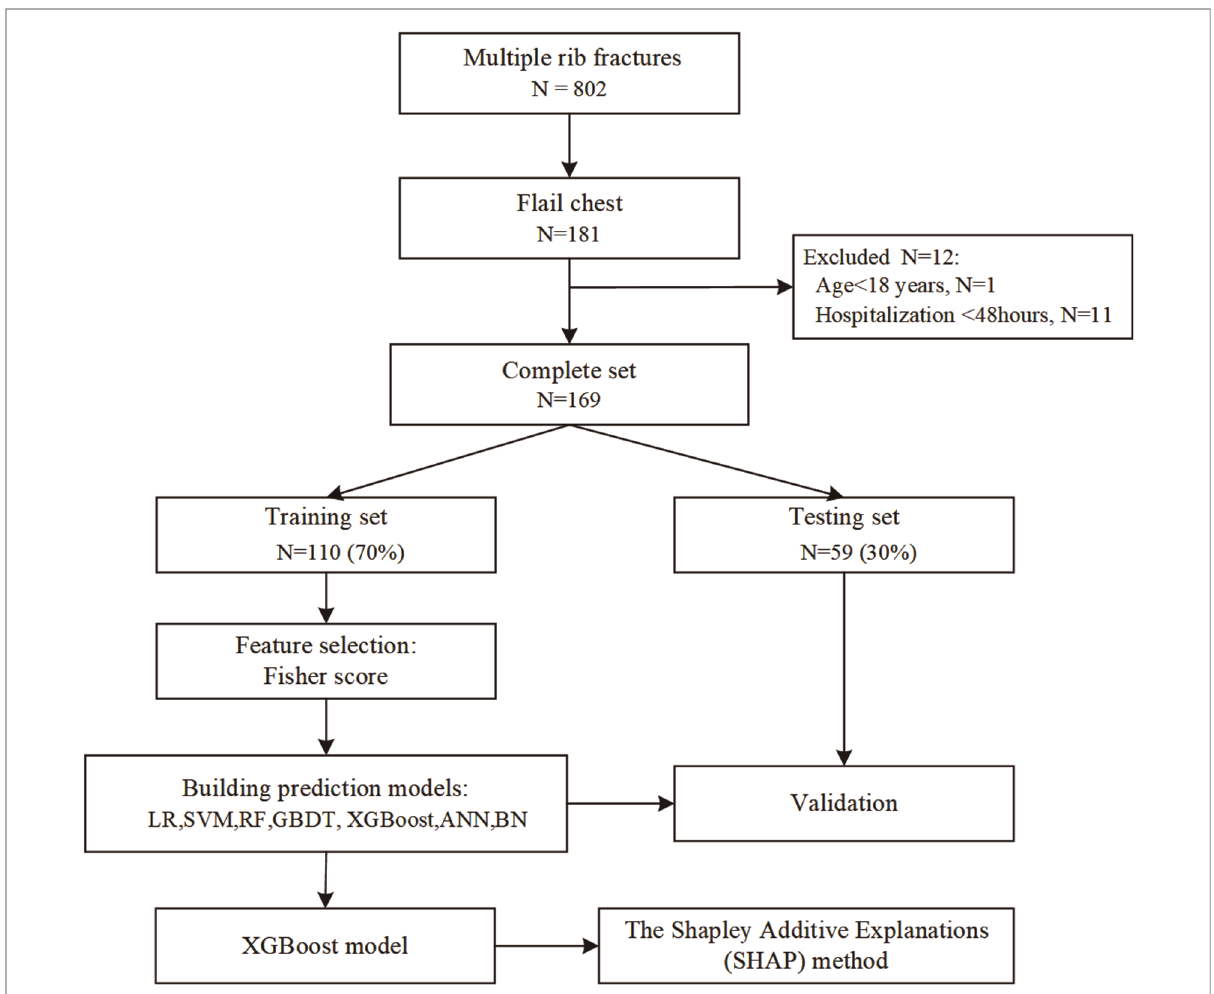
FIGURE 1 Flowchart for patient selection and dataset partitioning. LR, logistic regression; SVM, support vector machine; GBDT, gradient boosting decision tree; XGBoost, extreme gradient boosting; ANN, arti fi cial neural network; NB, naive